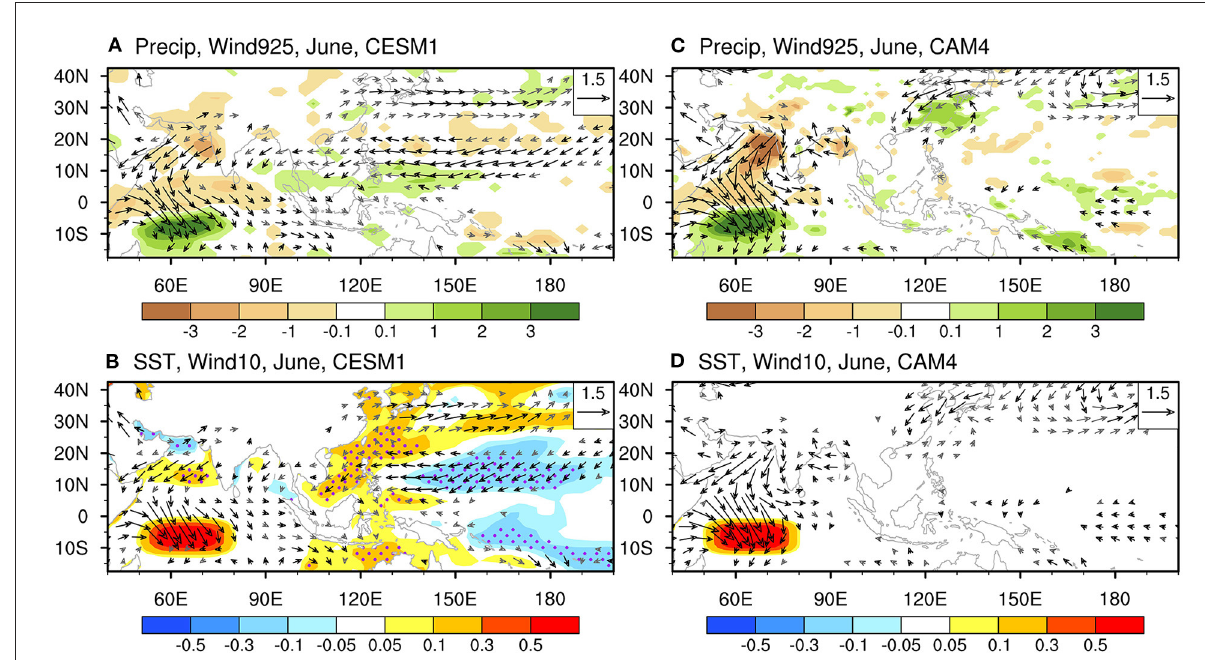
FIGURE15 Responses to southwest TIO SST warming in CESM1 using a partial coupling framework: (A) for precipitation (shading, mm day − 1 ) and low-level (i.e., 925-hPa) wind (vector, m s − 1 ) response, (B) for SST ( ◦ C) and 10 meter wind (vector, m s − 1 ) response. (C,D) showing the responses to southwest TIO SST warming in CAM4 (Atmospheric component of CESM1). The shading in (D) denotes the southwest TIO SST anomaly forcing using in CESM1 and CAM4. The shading in (A,C) , the stippling in (B) , and the black vector in (A–D) denote the response is significant at an 80% confidence level according to a student’s t